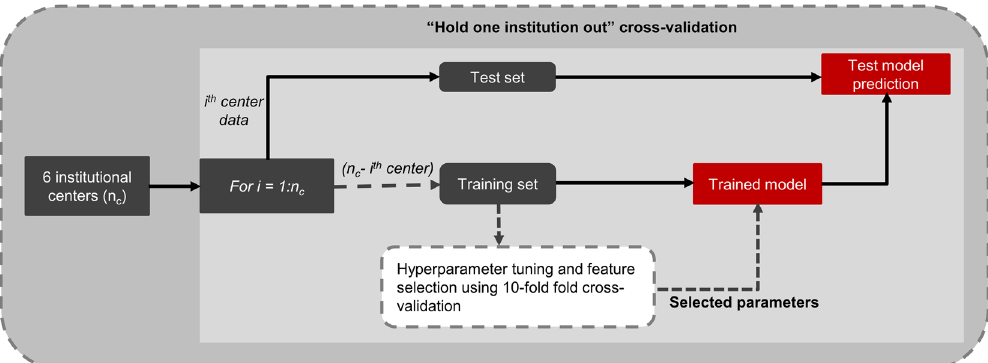
Figure 2. Schematic of the cross-validation scheme employed in support vector machine classifier training and testing across six institutional centers. At each iteration, data from one institution was held out for testing, and data from the remaining 5 institutions used for